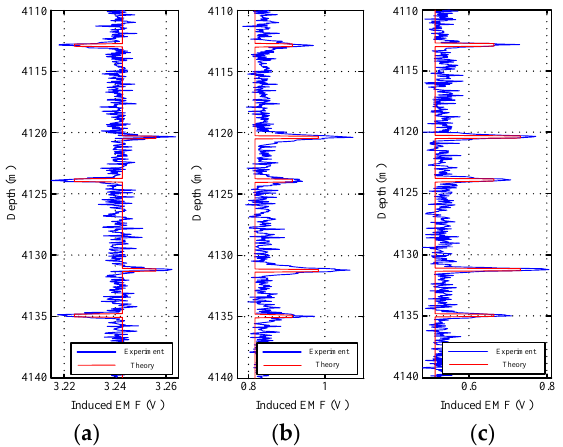
Figure 12. Induced EMF of the two sensors at different times ranging from 4110 to 4140 m: ( a ) main sensor at 20 ms; ( b ) main sensor at 50 ms; and ( c ) auxiliary sensor at 30 ms.